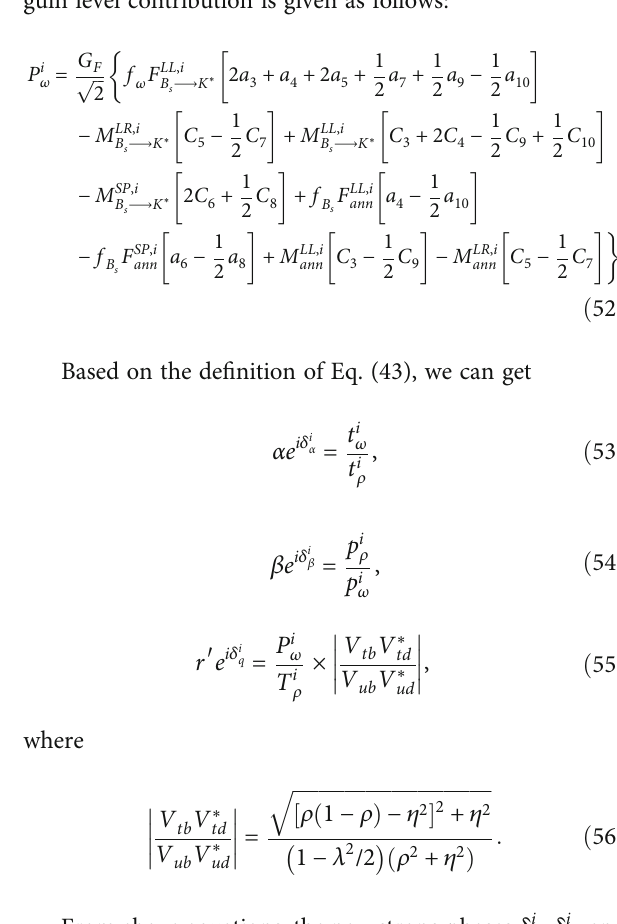
⟶ ρ 0 ð ω Þ K ∗ 0 s